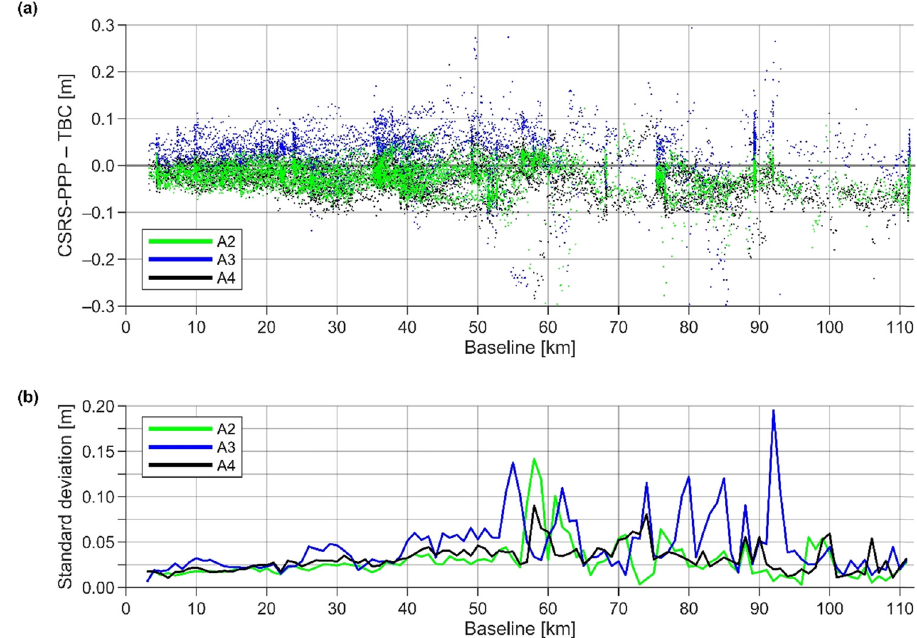
Figure 7: Di ff erences between the CSRS - PPP and TBC SSH solutions ( cf. Figure 6 ) in relation to TBC - associated baseline lengths ( a ) and di ff erences as a function of standard deviation ( b )